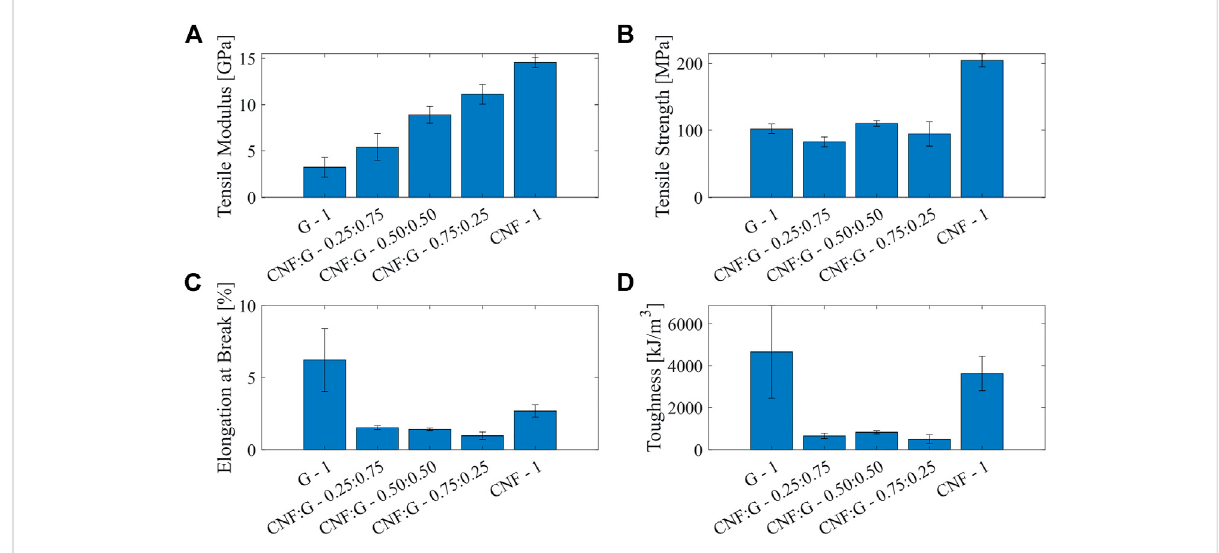
FIGURE 9 Results of the mechanical characterization of the humidity-responsive fi lms composed G — 1, CNF:G - 0.25:0.75, CNF:G — 0.50:0.50, CNF: G — 0.75:0.25 as well as CNF — 1. (A) gives the tensile moduli of the fi lms, (B) gives the tensile strength, (C) gives the elongation at break, (D) summarizes the tensile energy to break or toughness.